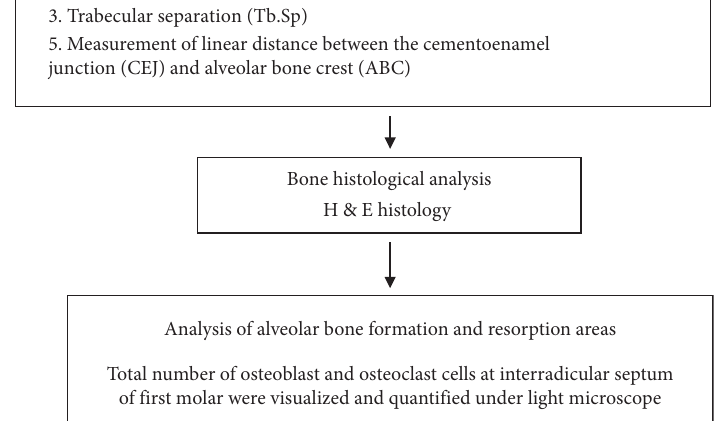
Figure 1: Flowchart diagram of the research methodology involving the stage of intervention, sacrifice, and bone morphometric and histological